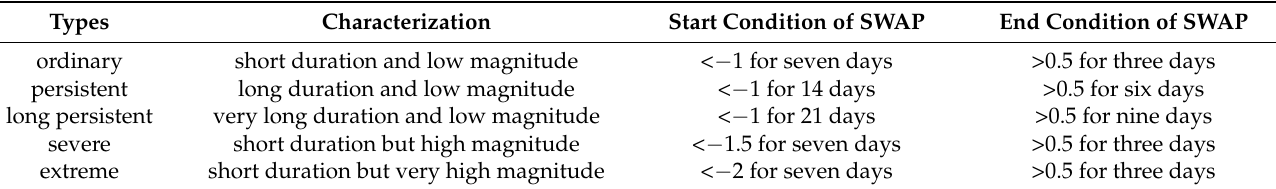
Table 2. Definition of five types of drought